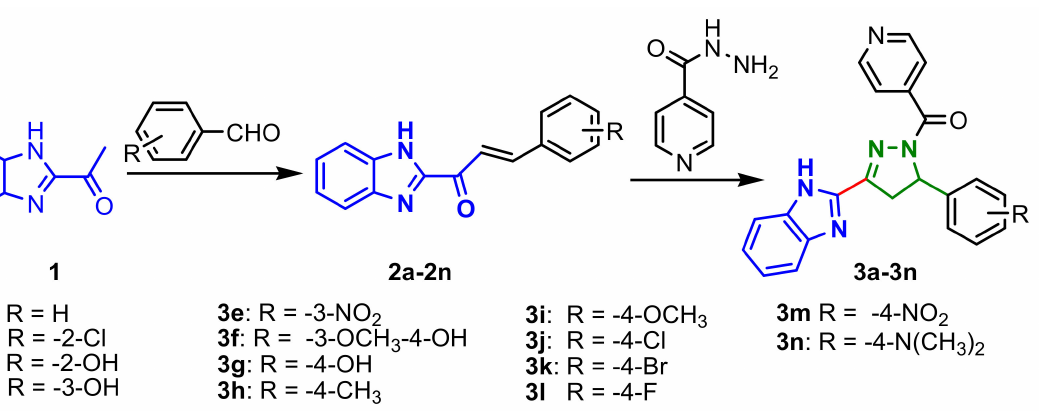
Scheme 1. Synthesis of benzimidazole–pyrazoles 3a – 3n